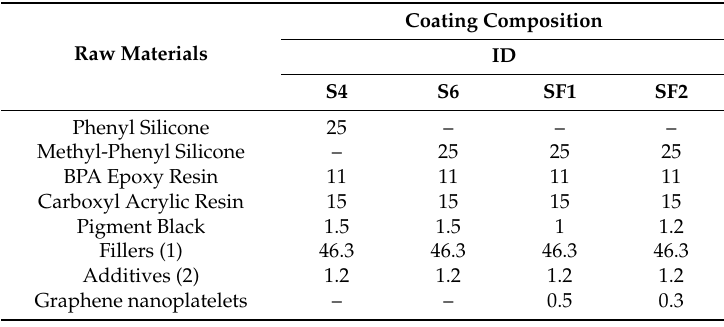
Table 1. Raw materials (wt %) and sample composition of selected samples *.